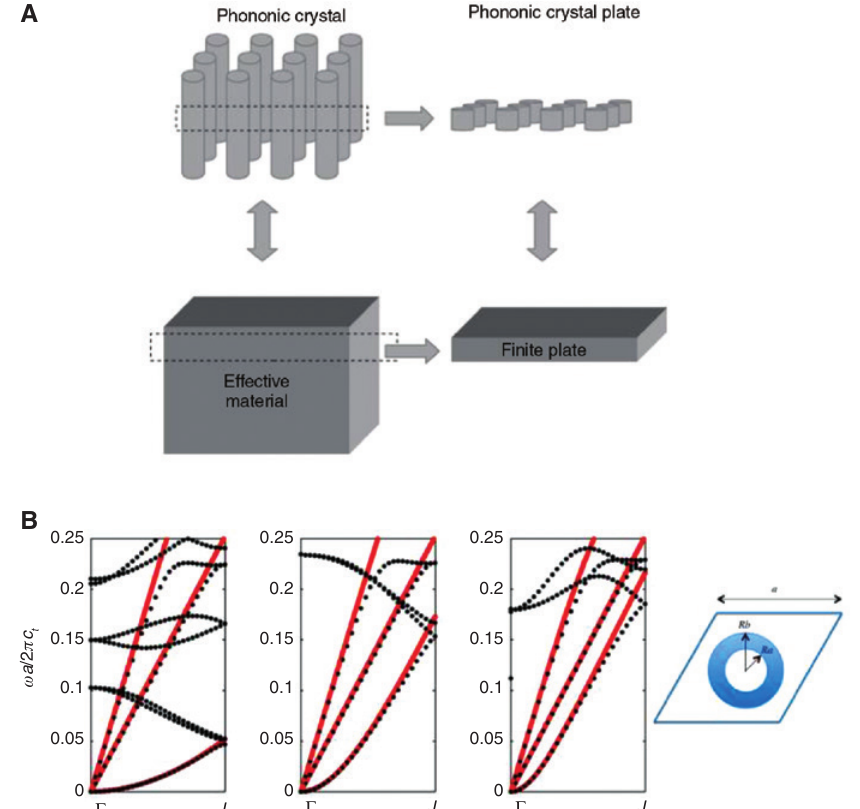
Figure 3: Homogenization of phononic crystal plates for all three fundamental Lamb modes. (A) Illustration of the homogenization relationship between phononic crystal and phononic crystal plate [26]. (B) Dispersion comparison of a phononic crystal plate between the finite element method (black dots) and the homogenization theory with effective parameters from Eq. (8) (red lines) for the plate thickness as 0.1 a (left), 0.5 a (middle) and a (right). The phononic crystal plate consists of a triangular lattice of hole-gold shell unit cell whose inner radius is 0.2 a and outer radius is 0.4 a